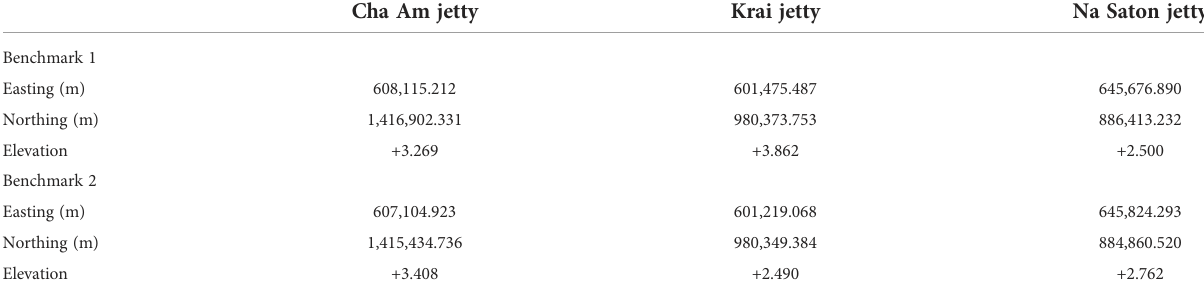
TABLE 3 Benchmark descriptions at the jetties in this study.